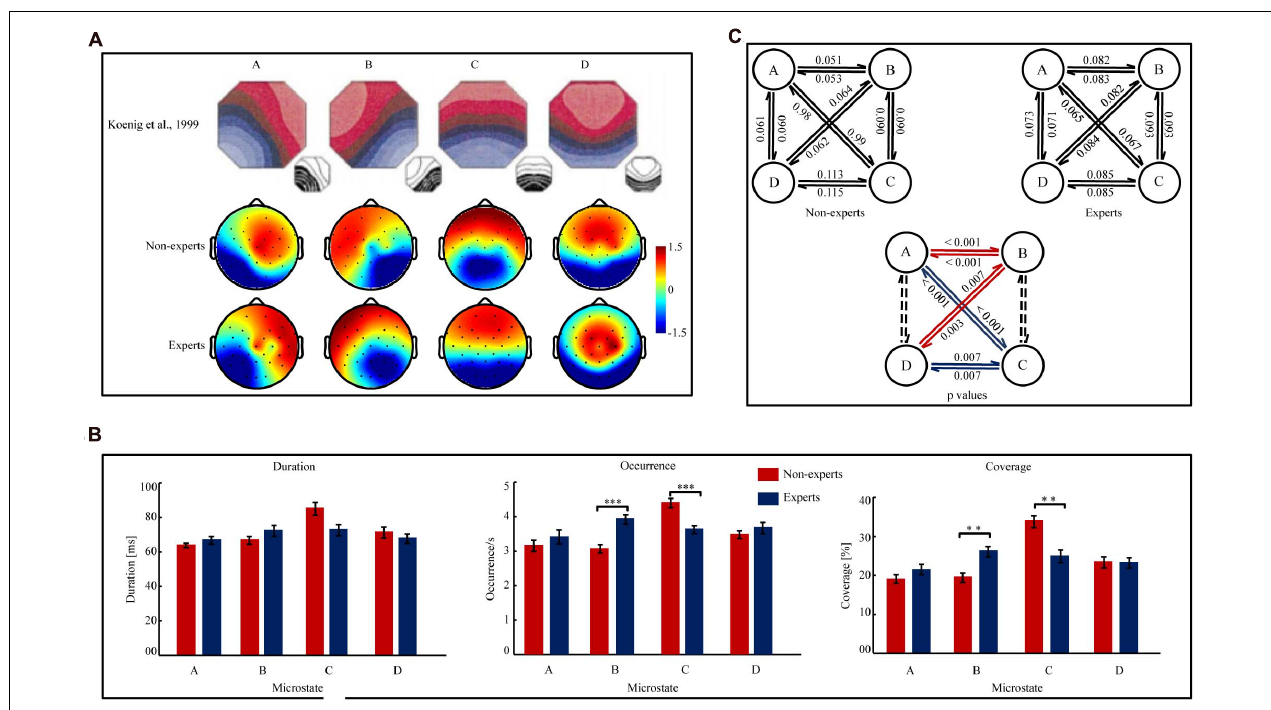
FIGURE 1 | The map topographies of microstate A, B, C, and D and the variables of the temporal complexity in the League of Legends (LOL) non-experts and experts. (A) The map topographies of microstate A, B, C, and D of the control group reported in Koenig et al. (1999) and the LOL non-experts and experts in the current study. Microstate A exhibits a left-right orientation, microstate B exhibits a right-left orientation, microstate C exhibits an anterior-posterior orientation, and microstate D exhibits a fronto-central maximum. The color bar of topographies ranges from –1.5 µ V to 1.5 µ v and the values indicate the average potential of global field potential (GFP). Red color indicates positive values and blue color indicates negative values (can be inverted). (B) The Mean duration, Occurrence, and Coverage of microstate A, B, C, and D in the LOL non-experts and experts. Error bars represent SEM ∗∗ p [ FDR ] < 0.01, ∗∗∗ p [ FDR ] < 0.001. (C) Figure 1C (the two figures in upper part of Figure 1C ) indicated the transition probabilities from one microstate to other microstate for all four microstates in the LOL non-experts and experts. The arrow indicated the transition direction from a given microstate to other one. The value on the arrow indicated the transition probabilities. Figure 1C (the one figure in the lower part of Figure 1C ) indicated the difference of the transition probabilities between the LOL non-experts and experts. The value on the arrow indicated the significant p [ FDR ] values of the transition probabilities between the LOL non-experts and experts. The red arrows indicated that the LOL experts had higher transition probabilities than the non-experts, while the blue arrows indicated that the LOL experts had lower transition probabilities than the non-experts. The dashed lines indicated transition probability did not significantly differ between groups.